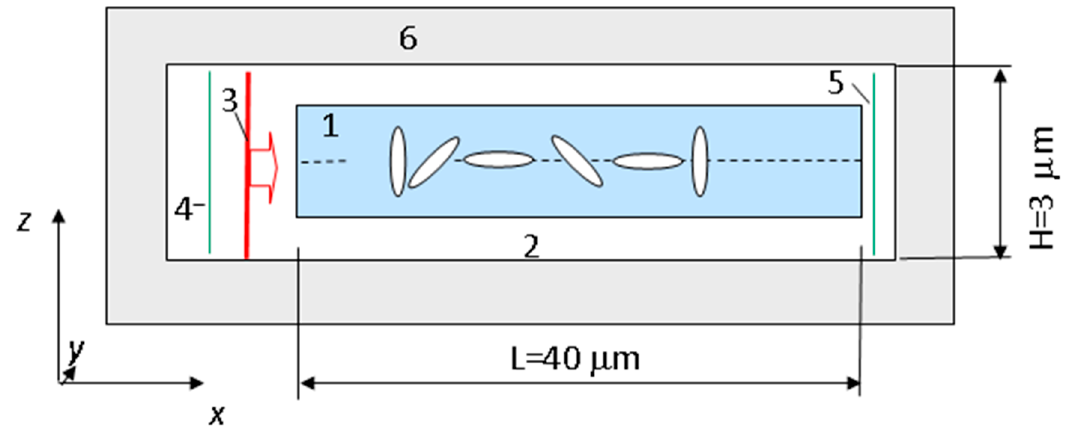
Figure 9. Scheme of the FDTD simulated domain. (1) LC grating layer; (2) the medium with a refractive index of 1.46; (3) unidirectional light source; (4) sensor for the reflected light; (5) sensor for the transmitted light; (6) the uniaxial perfectly matched layers.